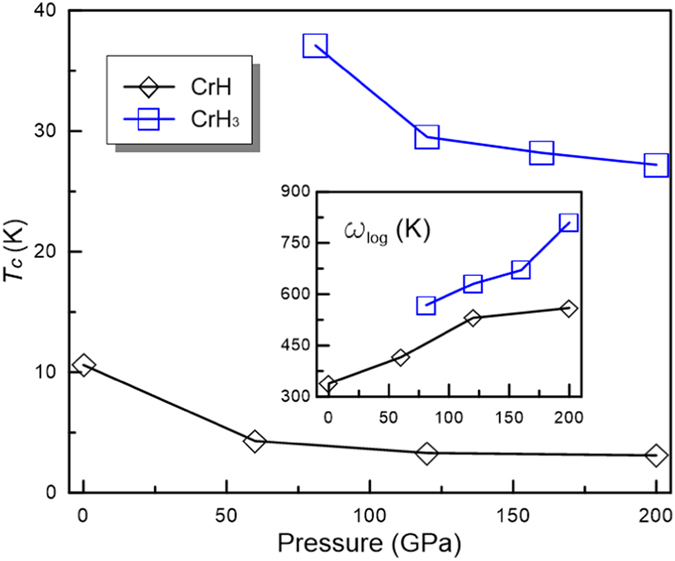
Pressure dependence of Tc for CrH and CrH3 phases. Inset shows the logarithmic average phonon frequency (ωlog) with pressure.